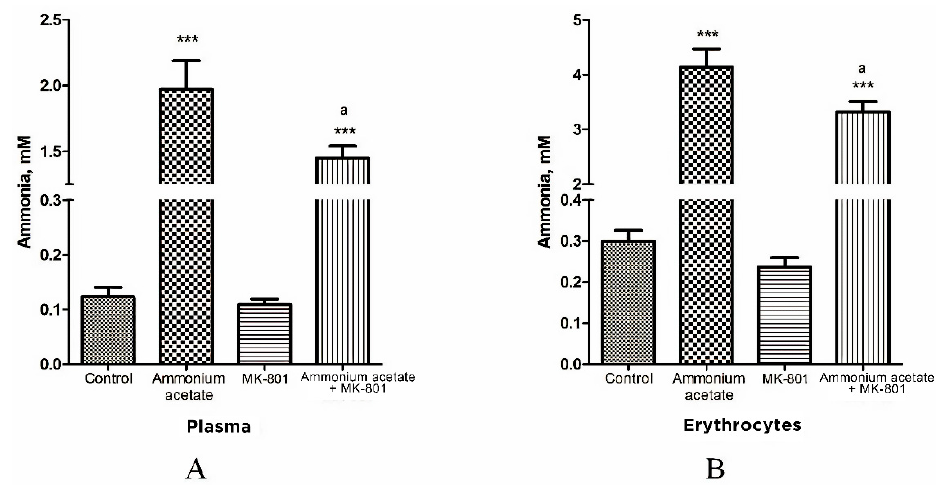
Figure 1. Ammonia concentration of plasma ( A ) and erythrocytes ( B ) in animals from different experimental groups. Rats ( n = 8 per group) were injected intraperitoneally with ammonium acetate (7 mmol/kg), MK-801 alone (2 mg/kg i.p.), and MK-801 15 min before ammonium acetate injection. Rats from the control group received a saline injection. Plasma and erythrocyte ammonia concentration was determined as indicated in Materials and Methods. The results are presented as mean ± SEM. Values significantly different from the control group are designated with three (***) asterisks: *** p < 0.001 (Student’s t -test). Values significantly different from the ammonia group are designated with a . а p < 0.05 (with the Bonferroni correction for multiple comparisons).